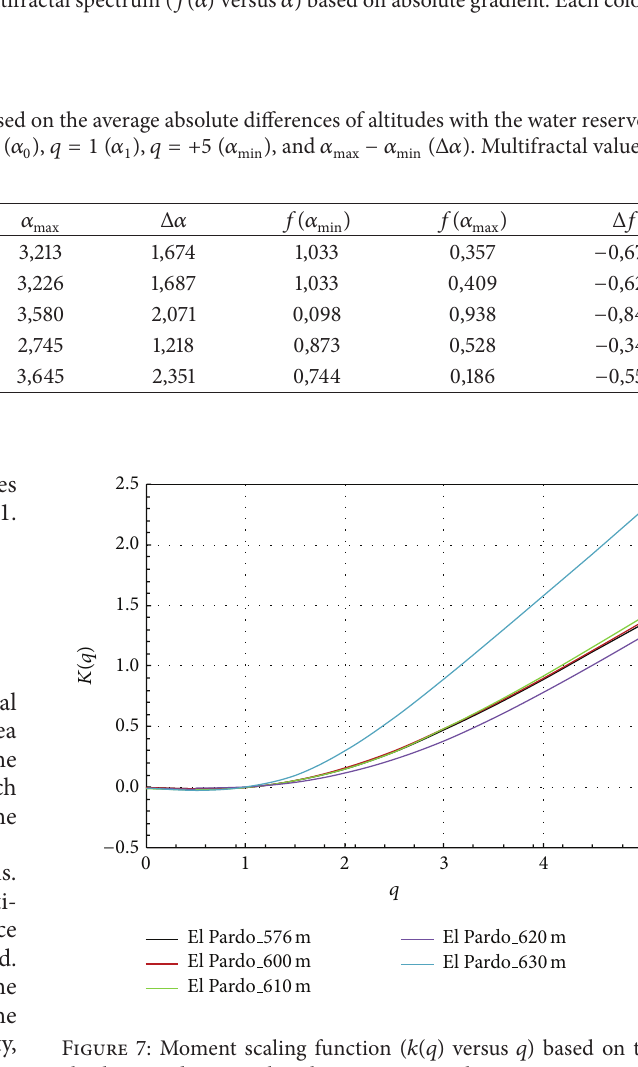
Figure 7: Moment scaling function ( 𝑘(𝑞) versus 𝑞 ) based on the absolute gradient. Each colour represents the water reservoir at different filling